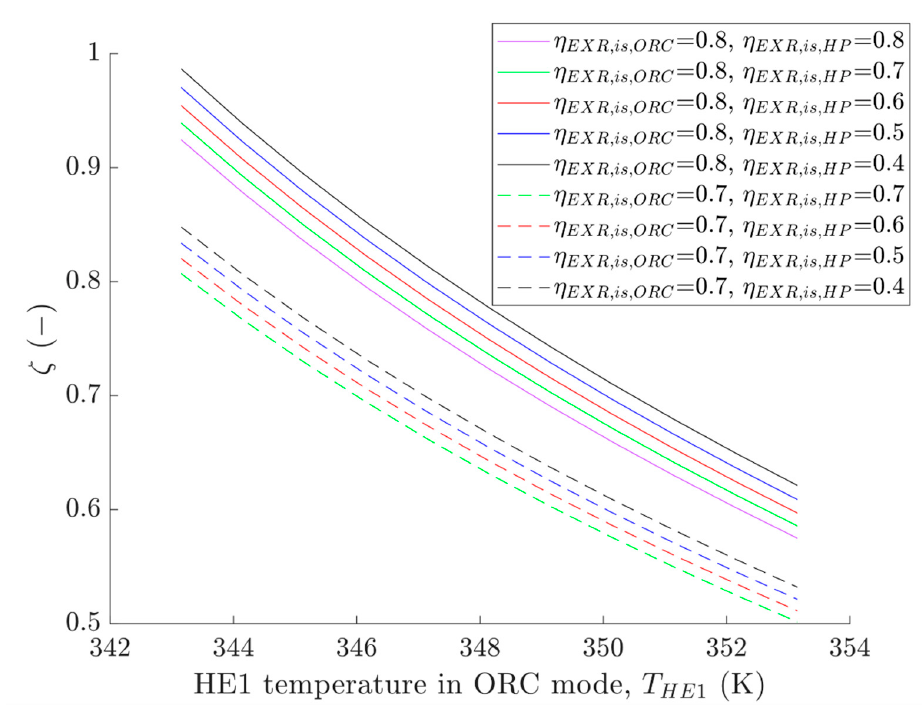
Figure 5. The variation in ζ for different values of T HE1 temperature and different expander isentropic efficiency.